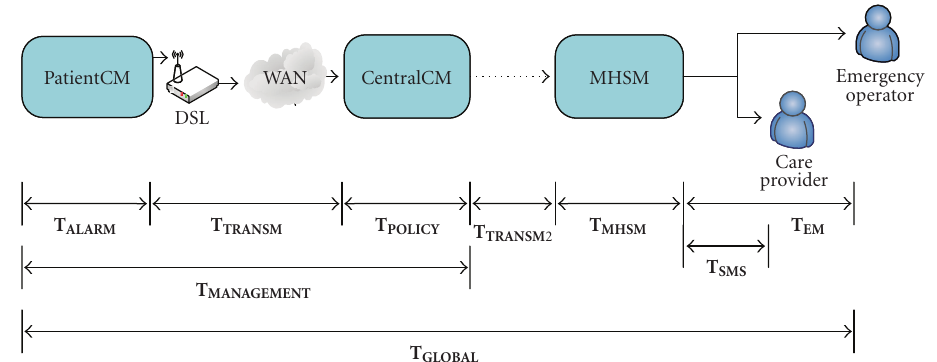
Figure 5: Time intervals for ERMHAN performance